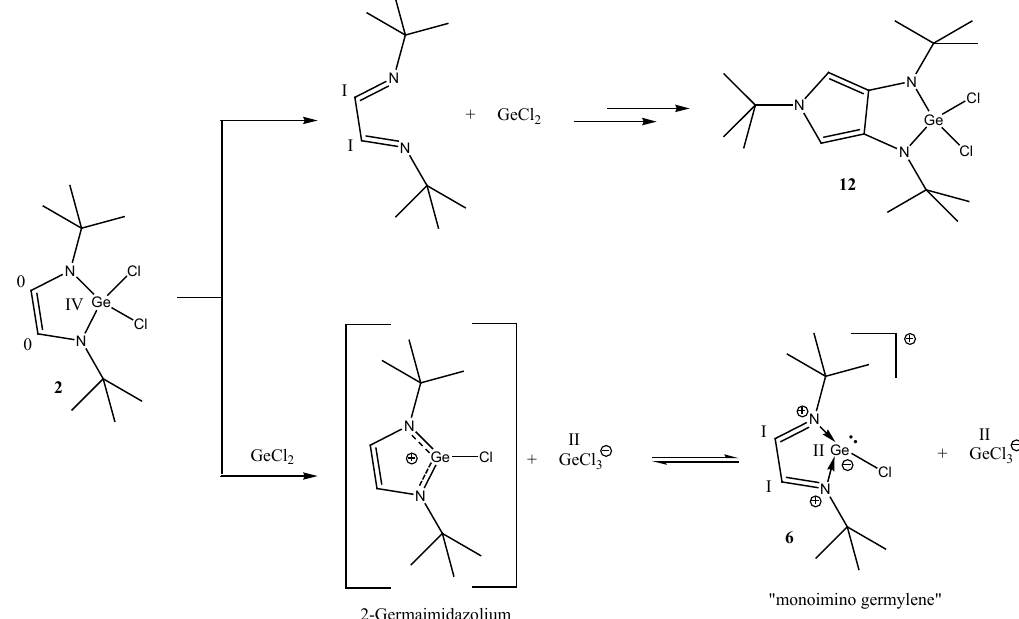
Scheme 6. Synthesis of the cationic monoimino germylene 6